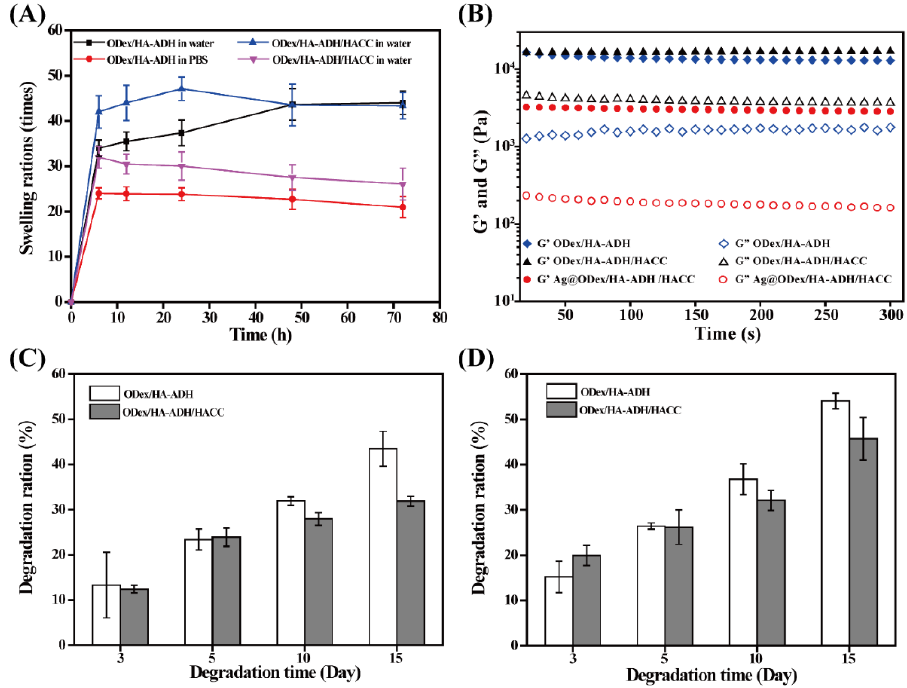
Figure 2. Swelling, in vitro degradation and rheology behaviors of hydrogels ( A ) Swelling ratios of the ODex/HA-ADH and ODex/HA-ADH/HACC hydrogel in pure water and PBS (pH = 7.4) at 37 °C. ( B ) Rheological performance of the different hydrogels. ( C ) The degradation rate of ODex/HA-ADH and ODex/HA-ADH/HACC hydrogels in PBS (pH = 7.4). ( D ) The degradation rate of ODex/HA-ADH and ODex/HA-ADH/HACC hydrogels in PBS (pH = 7.4) containing 100 U/mL hyaluronidase.